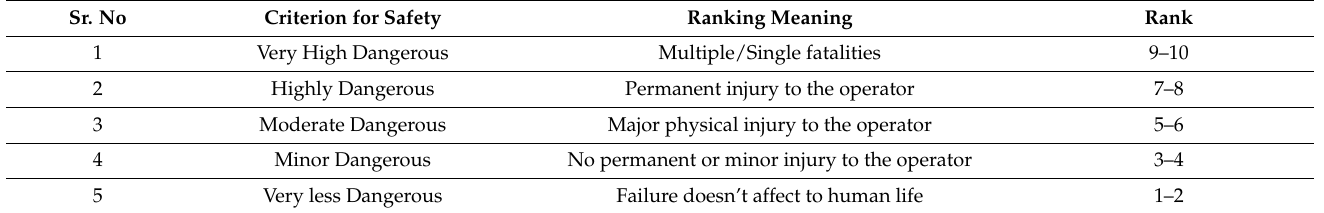
Table 5. FMECA scale to rate safety (S).